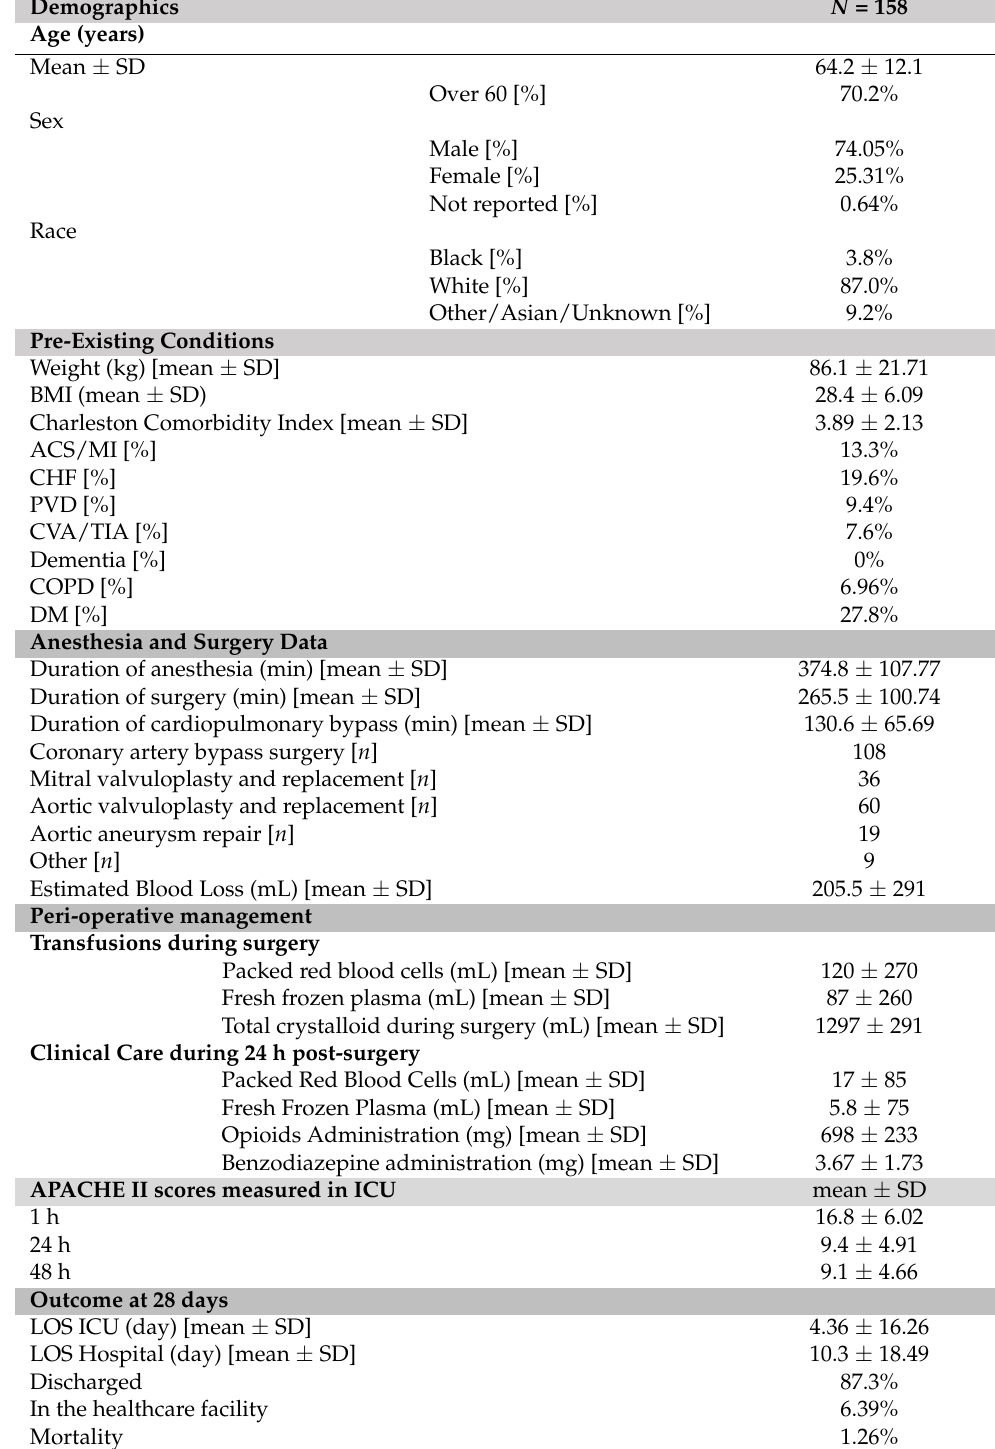
Table 1. Patient demographics and clinical